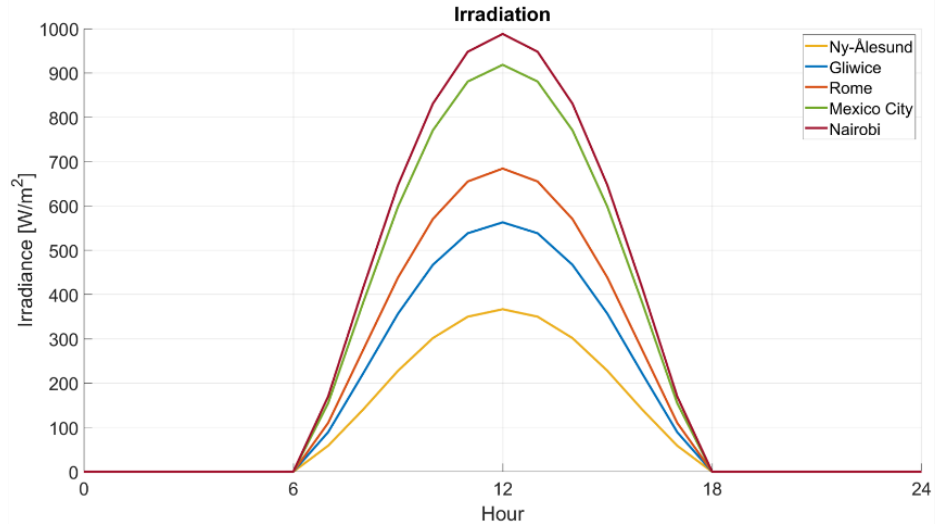
Figure 14. Irradiation for different location in the Vernal equinox.